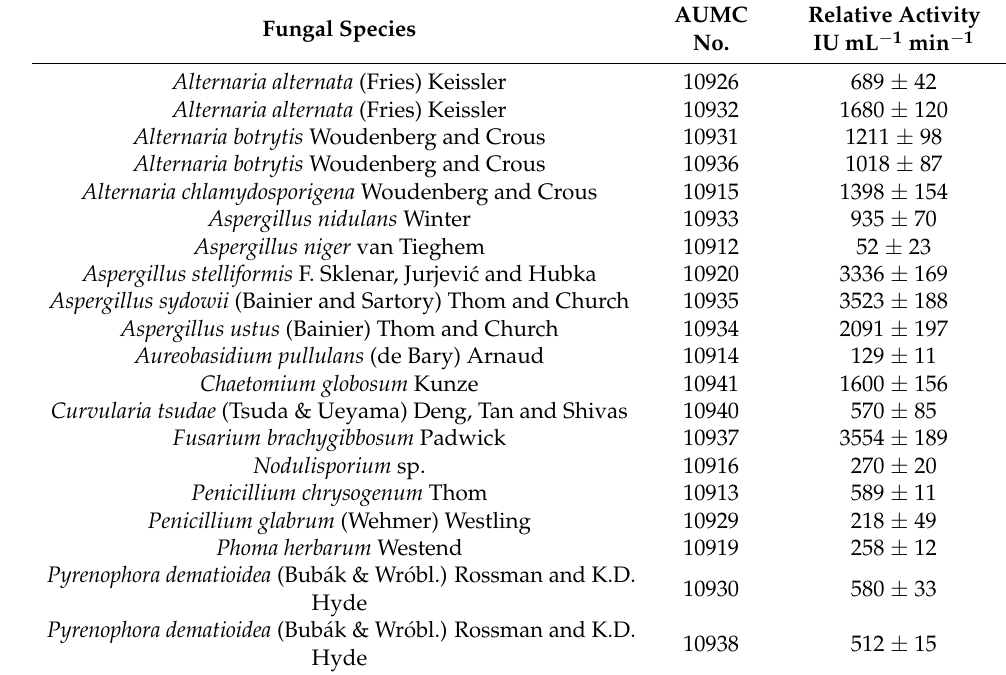
Table 1. Activity of fungal keratinases (mean ± SD, n = 3). AUMC no. = Culture Collection of the Assiut University Mycological Centre accession